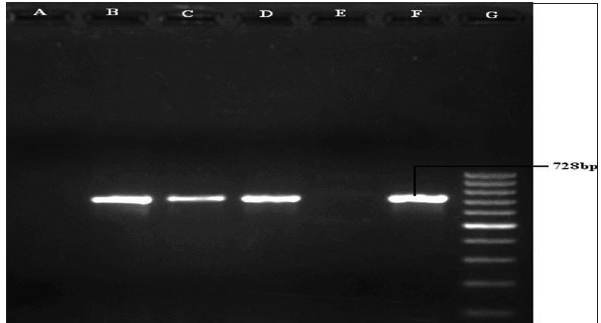
Figure-6: Polymerase chain reaction for the detection of tbpA gene (728 bp) of Pasteurella multocida. Lane B, C, D, and F: Samples positive for tbpA gene. Lane A and E: Samples negative for tbpA gene. Lane G: 100 bp DNA Ladder.